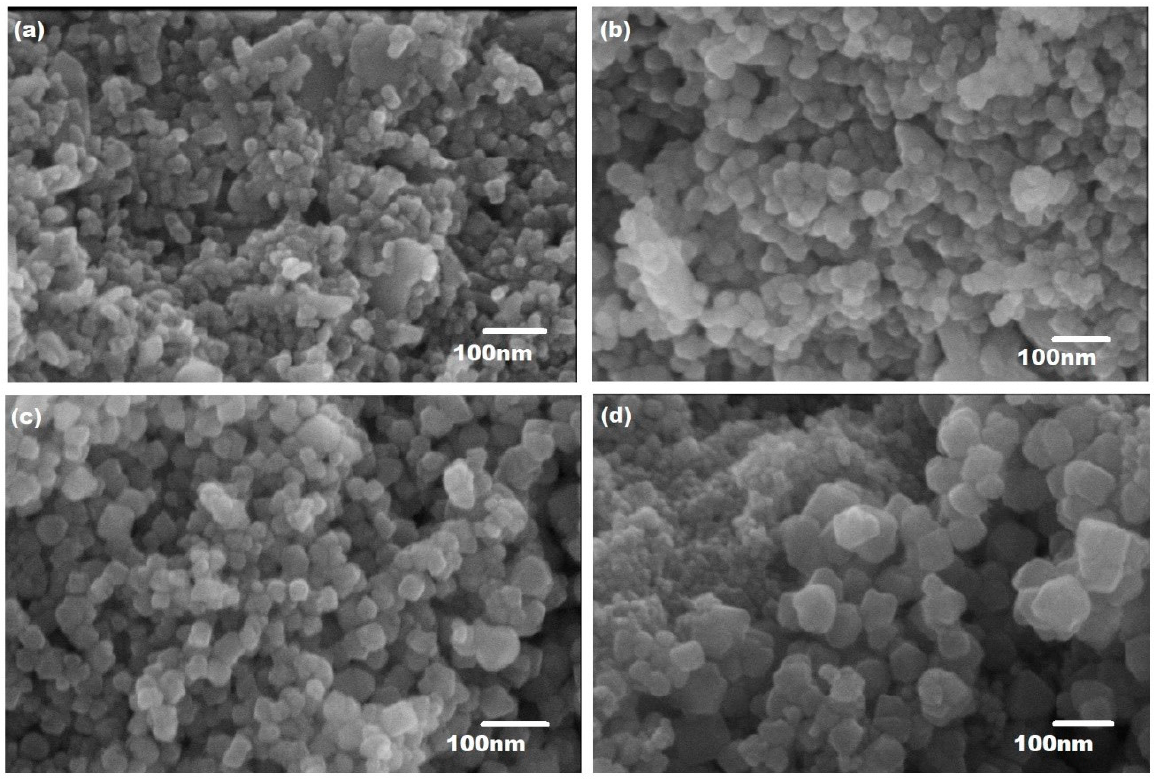
Figure 1. SEM images of Cu 2+ ‐ doped plant ‐ extracted CoFe 2 O 4 nanoparticles: ( a ) pure CoFe 2 O 4 , ( b ) Co 0.7 Cu 0.3 Fe 2 O 4 , ( c ) Co 0.4 Cu 0.6 Fe 2 O 4 and ( d ) Co 0.1 Cu 0.9 Fe 2 O 4 .